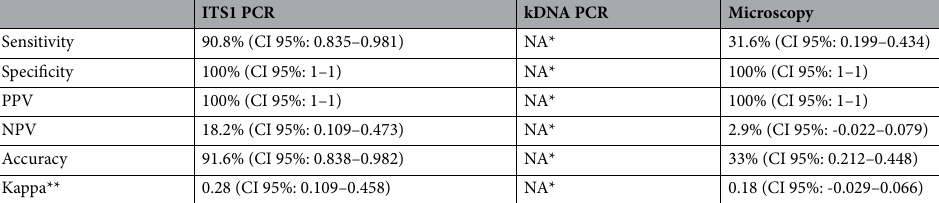
Table 3. Diagnostic performance and Kappa agreement of the study diagnostic tests. *NA: No statistics are computed because kDNA is a constant. **Key for Kappa: ˂ 0 = Poor agreement, 0.01-0.20 = Slight agreement,